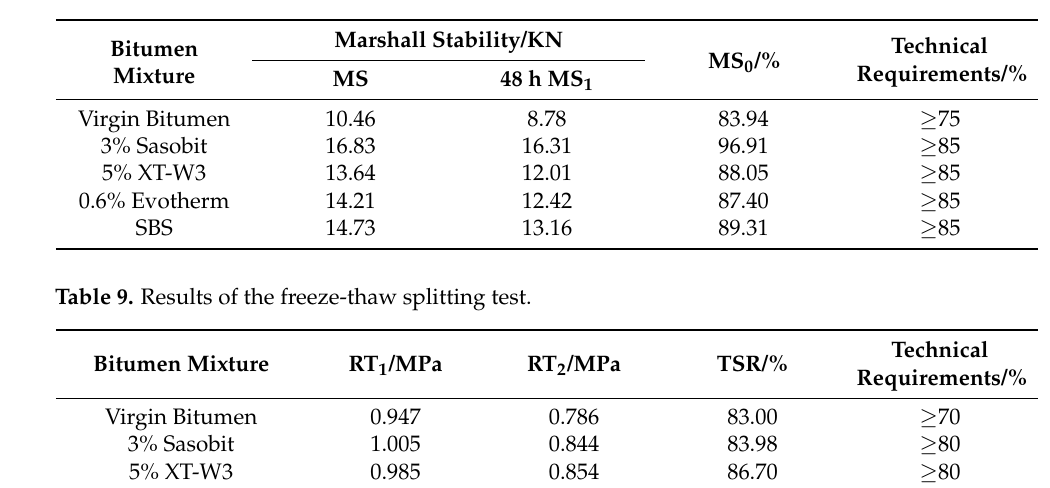
Table 8. Results of the soak Marshall test.